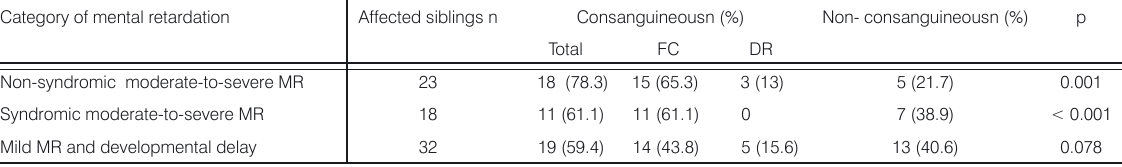
Table 4. Prevalence of Mental Retardation Spectrum Diseases Disorders in Village K of Offspring from Non-consanguineous Marriages and Different Degrees of Consanguineous